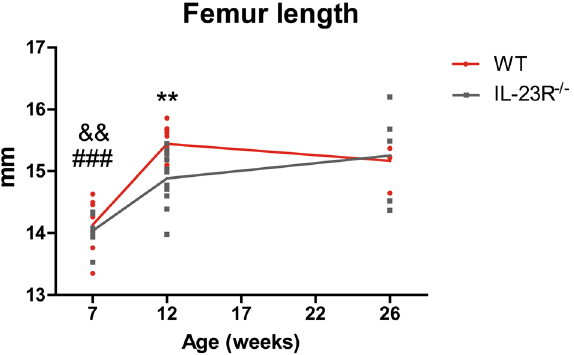
Figure 3. 12-week-old IL-23R deficient mice have shorter femurs compared to WT. Femur length of 7-, 12- and 26-week-old WT and IL-23R −/− mice was determined using μCT. Pooled data of n = 7 (7 weeks; two independent experiments), n = 11 (12 weeks; three independent experiments) and n = 5 (26 weeks; one experiment) mice per group. Data are depicted as mean ± SEM. *Significant difference between WT and IL-23R −/− mice at indicated age, # significantly different from 12 weeks within WT group, & significantly different from 12 weeks within IL-23R −/− group. ** or && p < 0.01, ### p < 0.001.